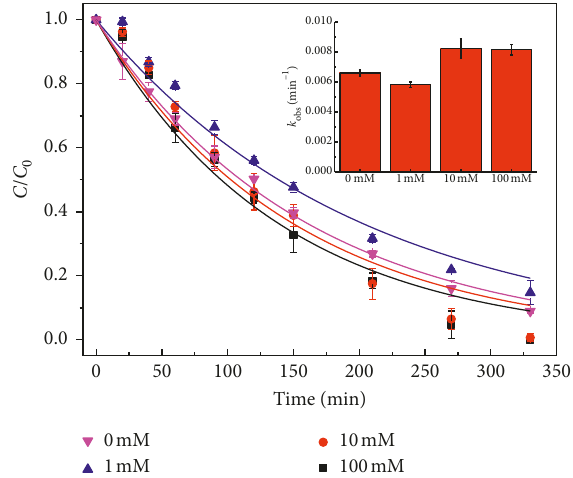
Figure 6: Effects of Cl − concentration on AMO degradation by TAP. Solid lines represent the pseudo-first-order kinetic model fits. Insert: changes of k obs at different Cl − concentrations. Experimental conditions: [AMO] 0 � 0.1mM; [PS] 0 � 10mM; T � 50 ° C; reaction time �